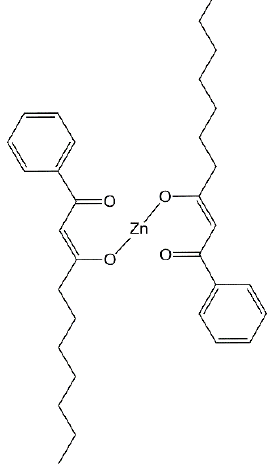
Figure 4. Structure of zinc 1-heptyl-3-phenylpropane-1,3-dione (HeBPP-Zn).